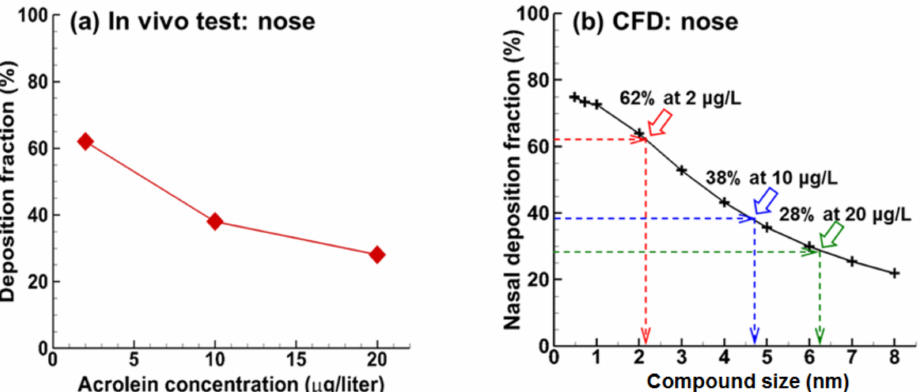
Figure 5. In vivo measured and CFD predicted deposition fractions of acrolein in the rat nose: ( a ) measured acrolein deposition fractions that decreased at higher inhalation concentrations [10] and ( b ) CFD predictions that decreased with decreasing diffusivity (equivalently, increasing particle size converted by the Stokes-Einstein equation, i.e., Equation (6)). The three points (indicated by arrows) in ( b ) correspond to the three measurement points in ( a